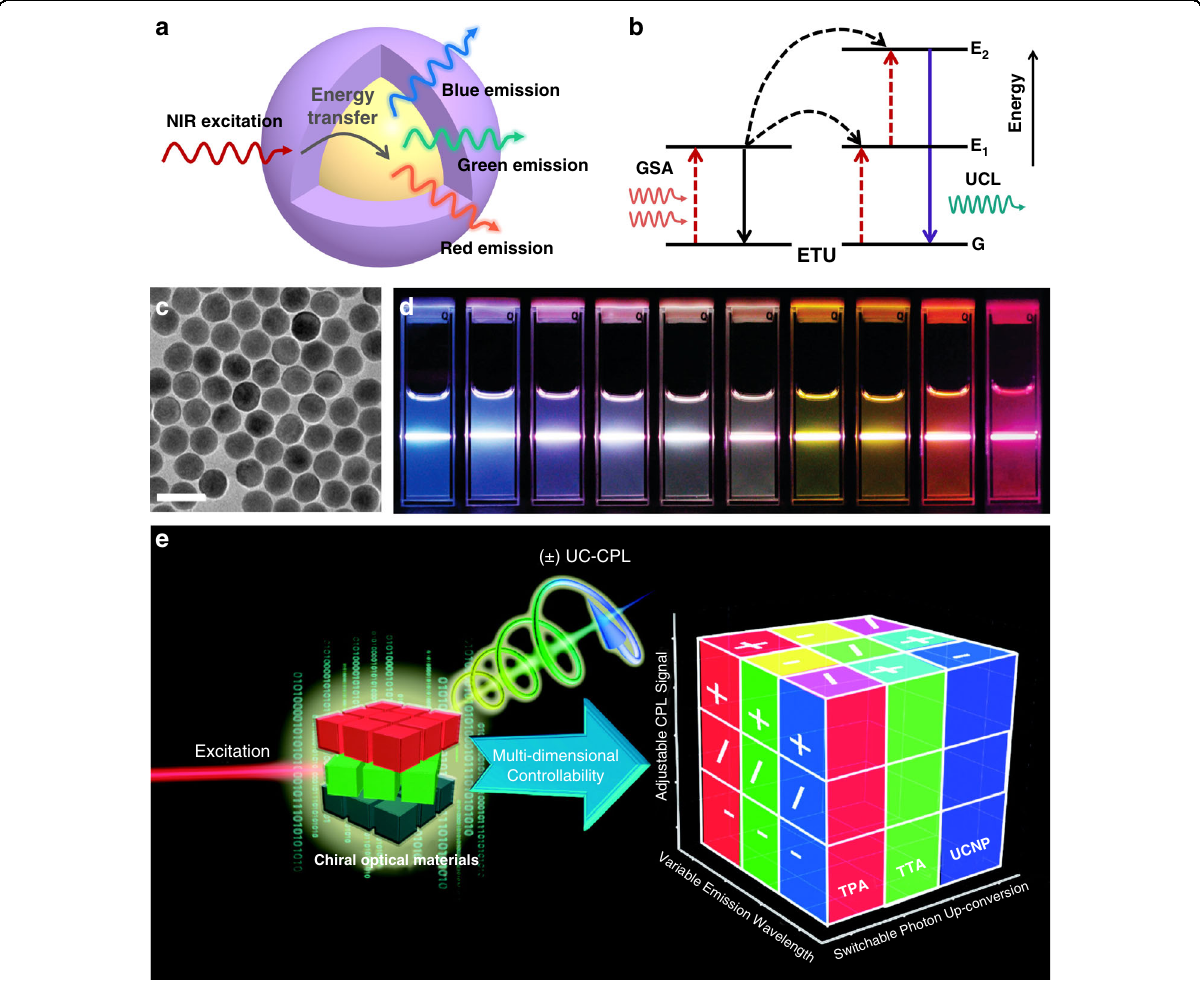
Fig. 11 Upconversion nanoparticles and their optical properties. a Schematic depiction of UCNPs. b ETU process of activators and sensitizers in UCNPs. c Typical TEM image of UCNPs (Scale bar, 50 nm). Reproduced with permission from ref. 291 . Copyright 2019, Springer Nature. d Tunable emissions of UCNPs excited with NIR light. Reproduced with permission from ref. 292 . Copyright 2008, American Chemical Society. e Schematic representation for multi-dimension information involved in chiral upconversion nanomaterials, including the CPL signal, the wavelength of emission, and excitation in photon upconversion. Reproduced with permission from ref. 293 . Copyright 2021, The Chemical Society of